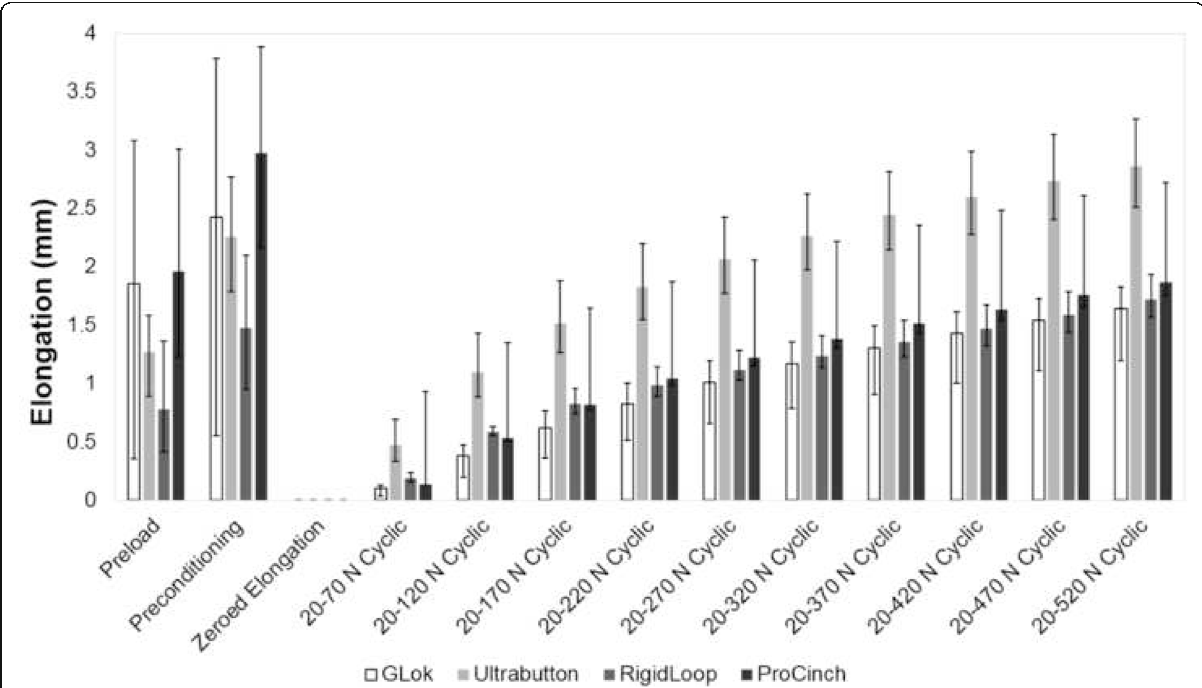
Fig. 5 Loop elongation at each loading stage for all